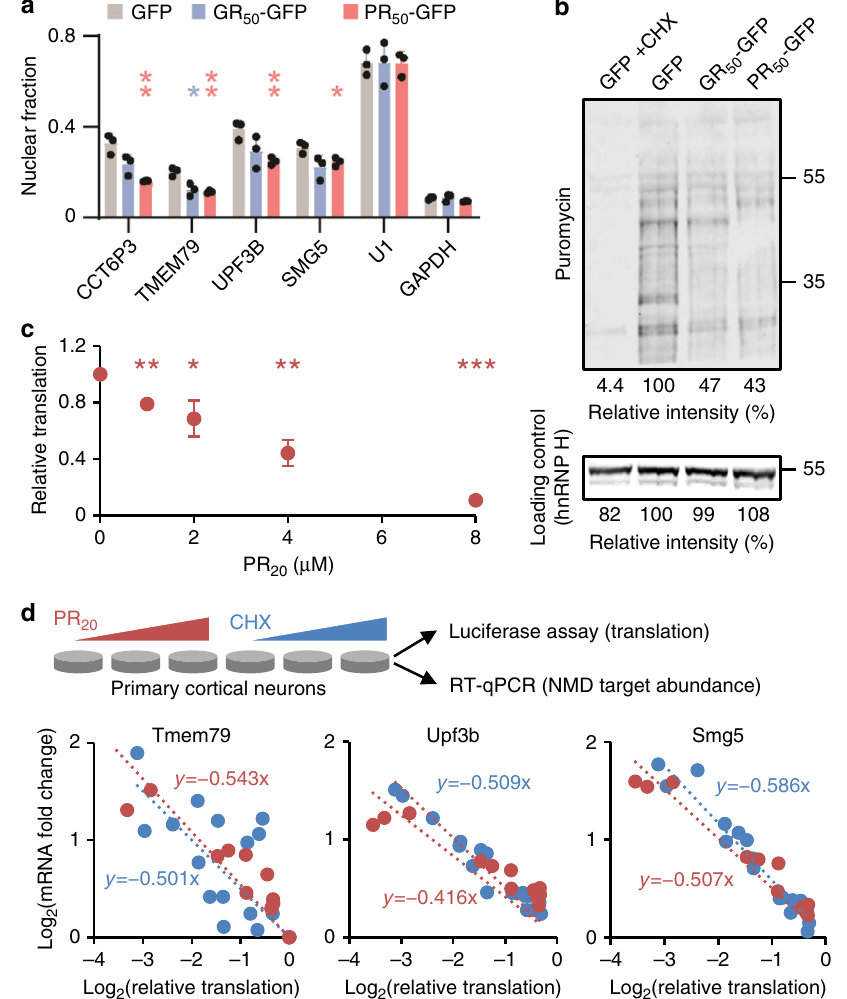
Fig. 4 Translation repression is the primary cause of poly(PR)-induced NMD inhibition. a Nuclear fractions of NMD targets, U1 snRNA, and GAPDH mRNA (cytoplasmic) in HEK293 cells expressing GFP, poly(GR), or poly(PR). n = 3 independent experiments. Data are presented as mean values± SD. * P < 0.05; ** P < 0.01, two-sided unpaired t tests. b Puromycin-labeled nascent peptides in HEK293 cells expressing GFP, poly(GR), or poly(PR). + CHX, CHX added 1 h before puromycin labeling. Similar results were obtained from three independent experiments. c Global translation levels in primary neurons treated with PR 20 for 24 h, quanti fi ed by the activity of a transfected luciferase reporter, normalized to mRNA levels and untreated control. n = 3 independent experiments. Data are presented as mean values ± SD. * P < 0.05; ** P < 0.01; *** P < 0.001, two-sided ratio t tests. d Comparisons between the effects of PR 20 (red) and CHX (blue) on NMD targets. Degrees of translation repression and NMD target abundance were quanti fi ed in primary neurons treated with increasing concentrations of PR 20 or CHX. Zero-intercept linear functions were fi t to normalized, log 2 -transformed values. Source data and exact P values are provided in the Source Data fi